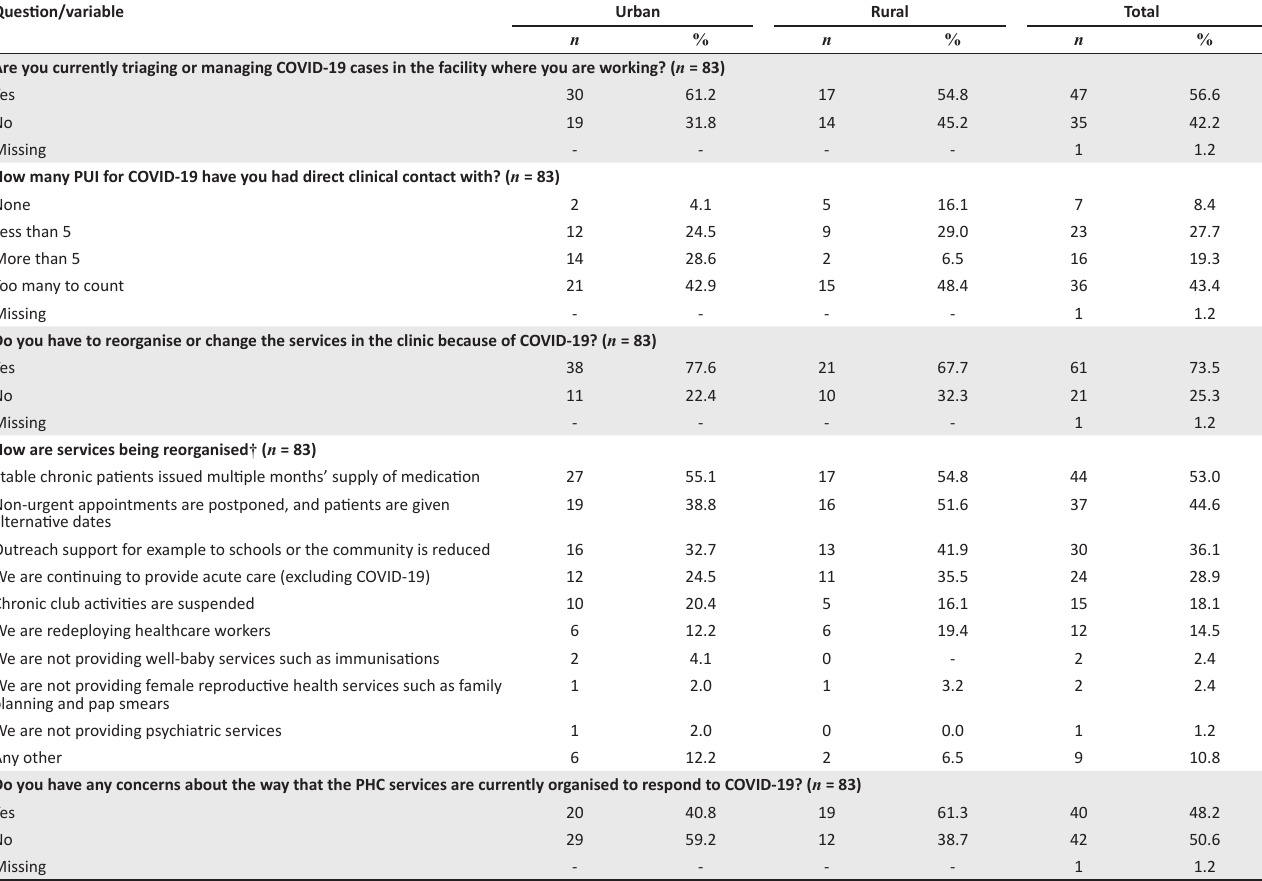
FIGURE 1: Districts participants were working TABLE 1: Reorganisation of services.